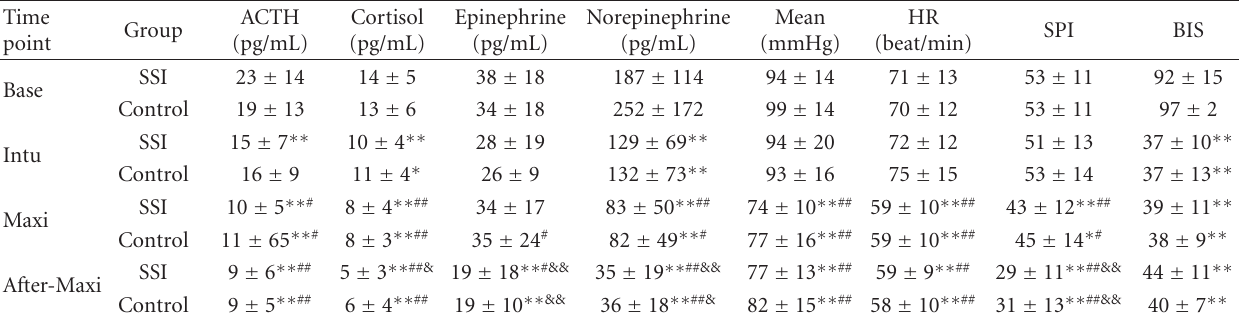
Table 3: Stress hormones levels, mean Bp, heart rate, SPI, and BIS values at the di ff erent event-related time points. Time point